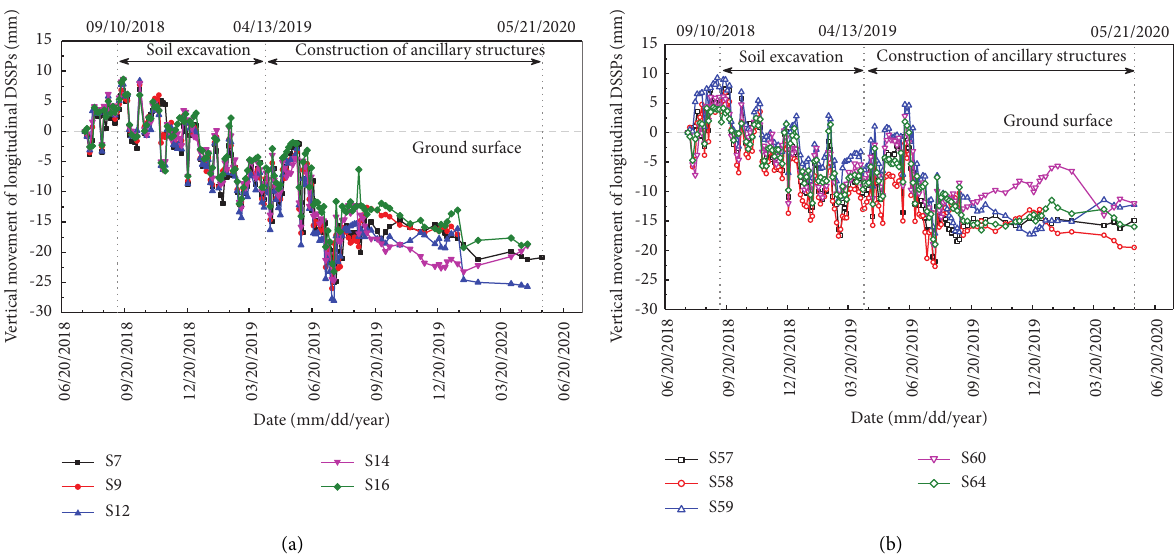
Figure 8: Development of the vertical movements of the longitudinal DSSPs during construction. (a) On the north side of Zone #1 and (b) on the south side of Zone #1.